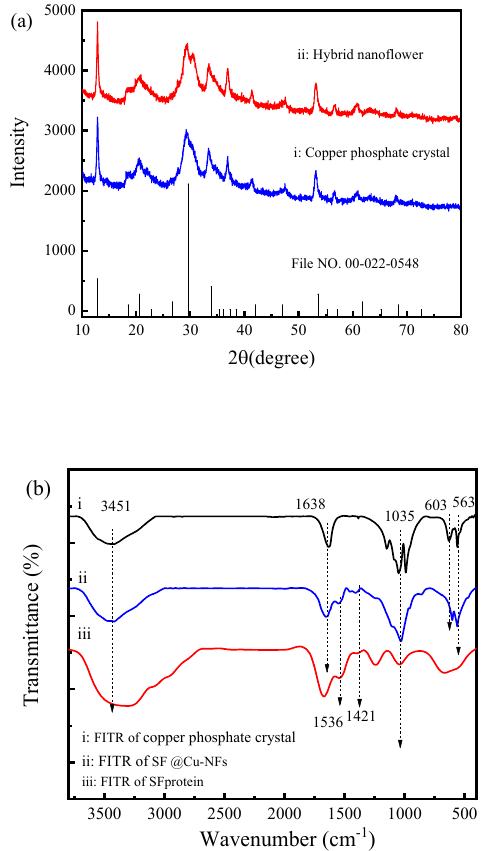
Figure 5. ( a ) XRD spectrum of (i) copper phosphate; (ii) SF@Cu ‐ NFs nanoflower. ( b ) FTIR spectrum of (i) copper phosphate; (ii) SF@Cu ‐ NFs nanoflower; (iii) SF